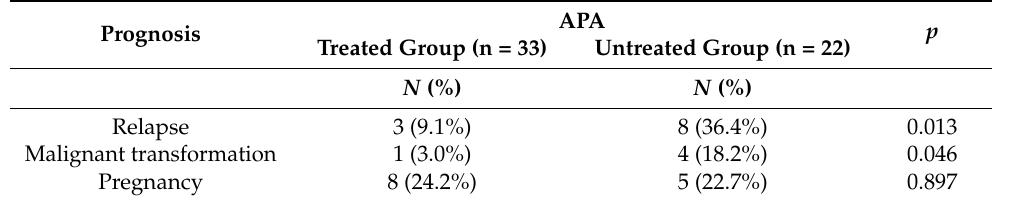
Table 2. Effect of adjuvant therapy after conservative surgery in APA.